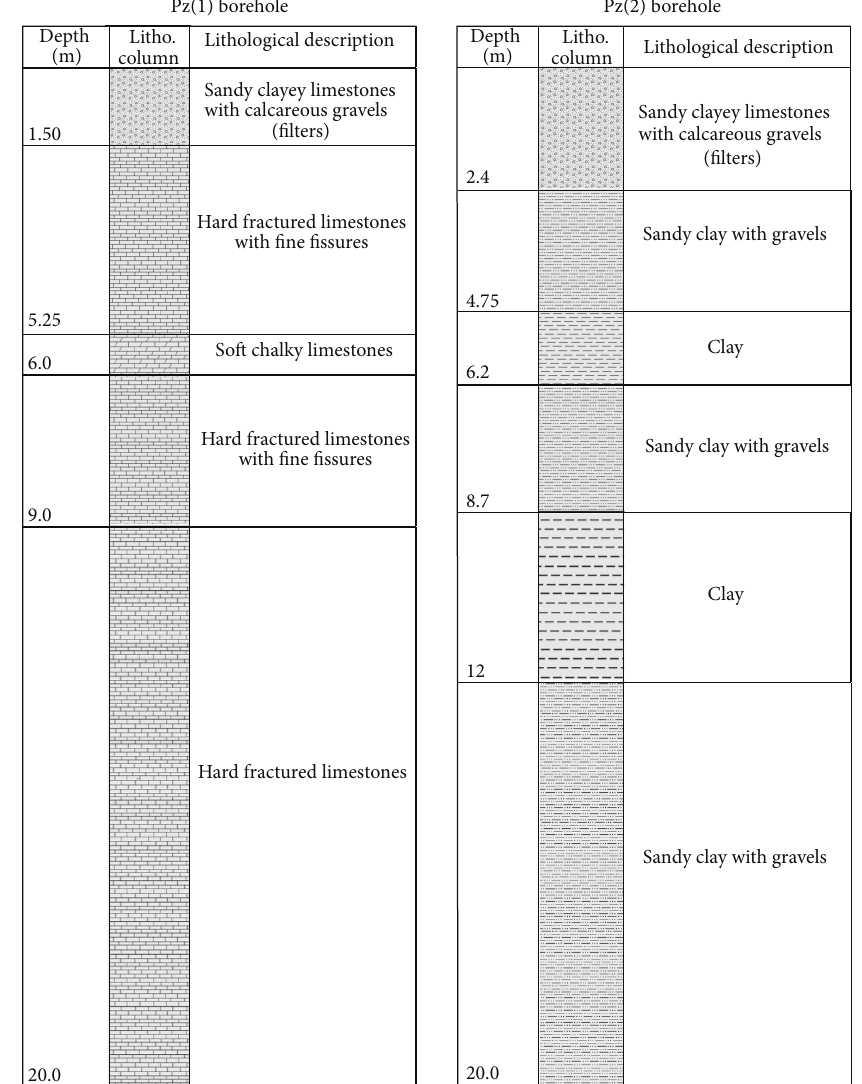
Figure 5: Comparison between lithological logs of the boreholes Pz(1) and Pz(2) drilled directly behind the dam body, modified after [20].